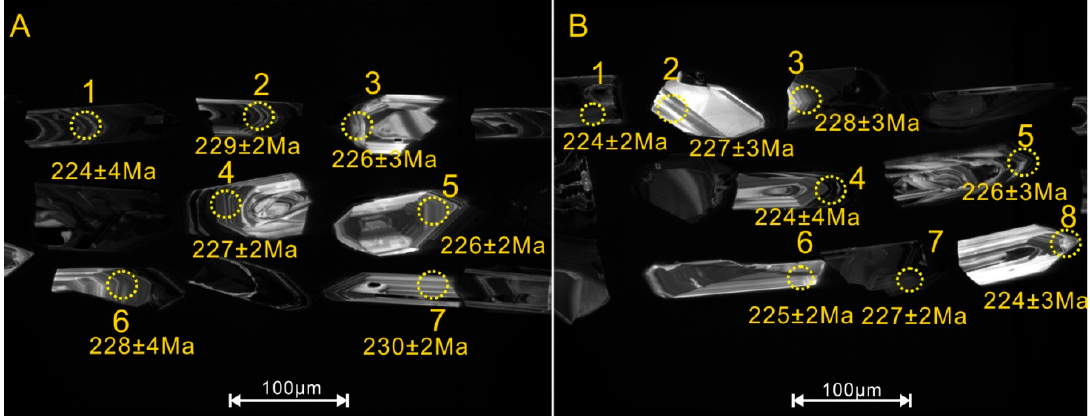
Figure 5. Cathodoluminescence images of zircons from the BAS. ( A ) BLC-1and ( B ) BLC-2.